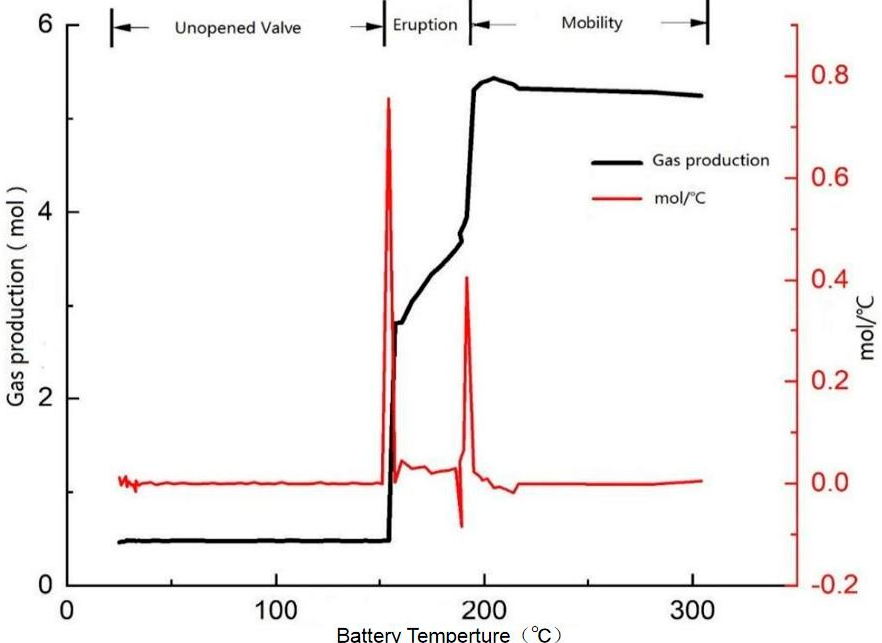
Figure 10. Gas production of the cell versus cell temperature. Stages of battery gas generation are divided. Following the initial valve opening, the temperature-dependent gas production steadily rises.